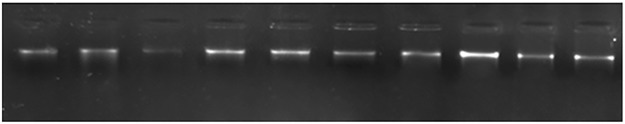
Genomic DNA isolation from healthy and infected skin.The concentration of DNA from healthy skin is lower (lanes 1–3, mean 1.9 ng/μl) as compared to infected skin (lanes 4–10, mean 19.5 ng/μl)